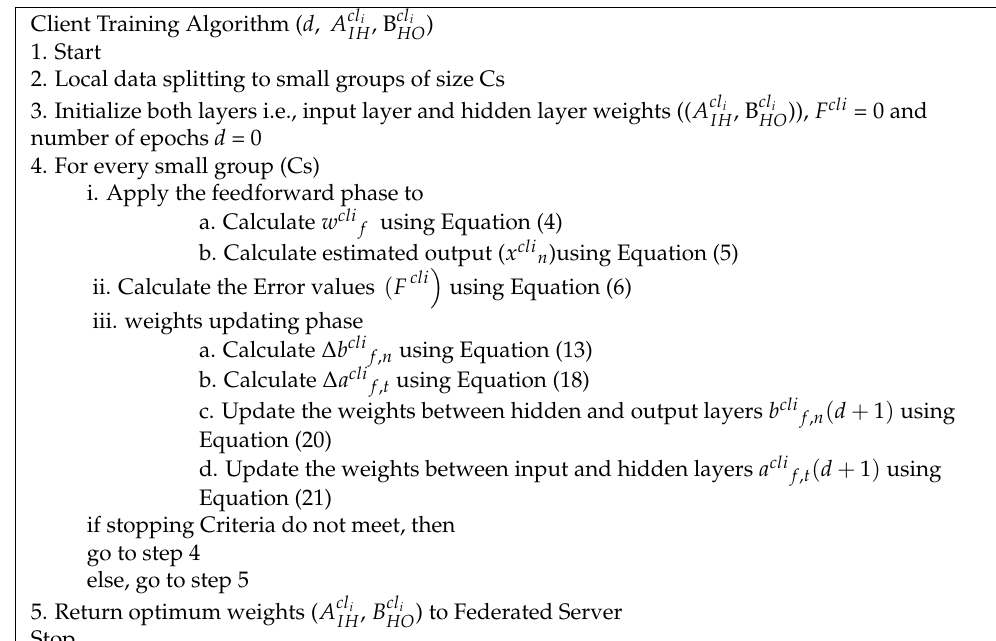
Table 1. Proposed i th client machine learning pseudo